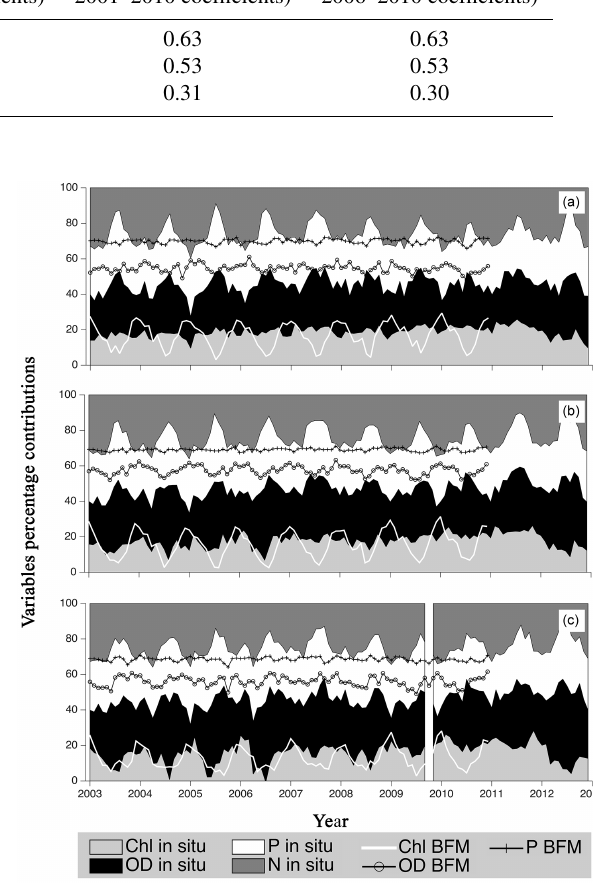
Figure 3. Percentage contributions of the four variables (Chl, DO, DIN, and TP) calculated as in Eq. (4) to the in situ TRIX (colored areas) and the model TRIX index (continuous lines with different symbols) in the three study areas (A, B, and